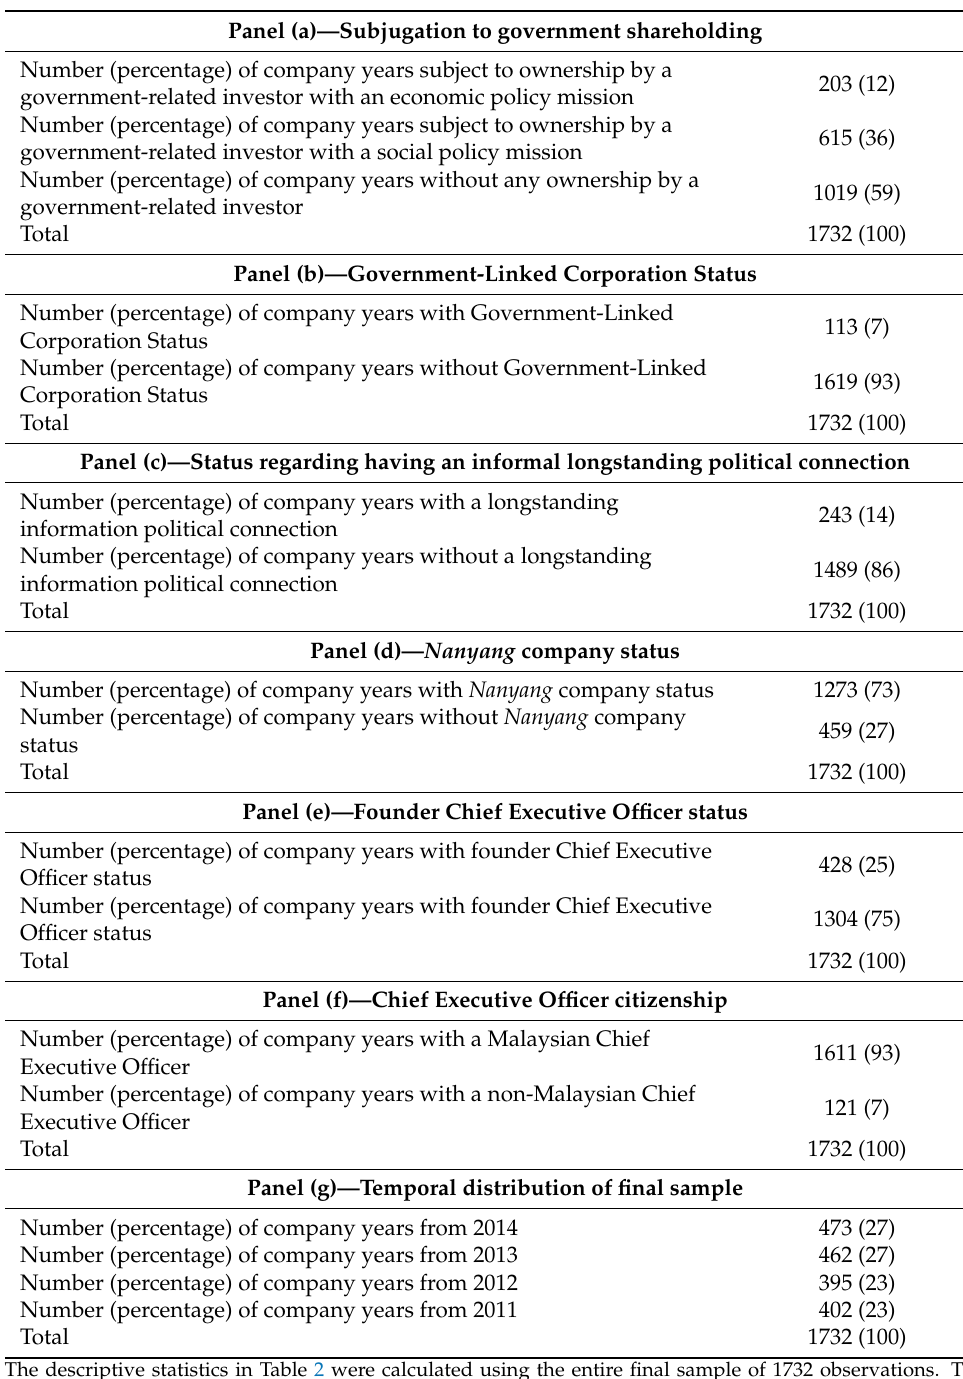
Table 2. Univariate statistics—Categorical